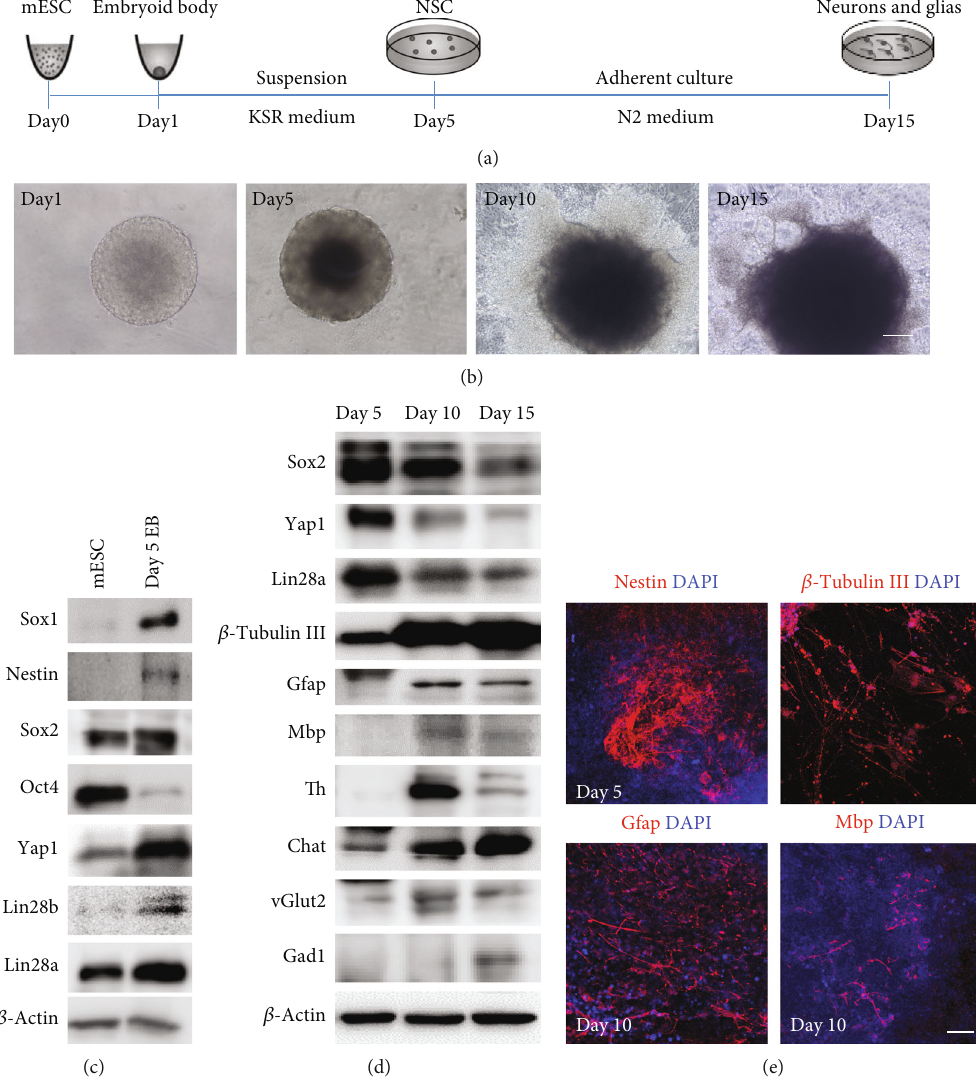
Figure 2: Establishment of the in vitro di ff erentiation protocol from mouse ESCs to neuronal and glial lineage cells. (a) A schematic drawing of the direct di ff erentiation assay from mouse ESCs to neuronal and glial lineage cells. ESCs were cultured under feeder-free condition with 2i + LIF medium for 1 day and then disassociated to single cells and quickly aggregated in di ff erentiation medium for one day. After 5 days of suspension culture in KSR medium, the aggregates were subjected to adhesion culture for another 10 or 15 days in N2 medium. (b) Phase-contrast microscopy of mouse ESC di ff erentiated cells on days 1, 5, 10, and 15. Scale bar, 200 μ m. (c) Western blot analyses of total proteins from mESC di ff erentiated cells on day 0 and 5 using the indicated antibodies. Mouse ESC pluripotent markers: Oct4 and Sox2, neural stem cell markers: Sox1, Nestin, and Sox2. (d) Western blot analyses of total proteins from mouse ESC di ff erentiated cells on days 5, 10, and 15 using the indicated antibodies. Neuronal marker: β -tubulin III, glial markers: Gfap and Mbp, neuronal subtype markers: Th, vGlut2, Gad1, and Chat. (e) Immuno fl uorescence staining of the neural stem cell marker Nestin on day 5, neuronal marker β -tubulin III and glial markers Gfap and Mbp on day 10. Cell nuclear was stained with DAPI. Scale bar, 200 μ